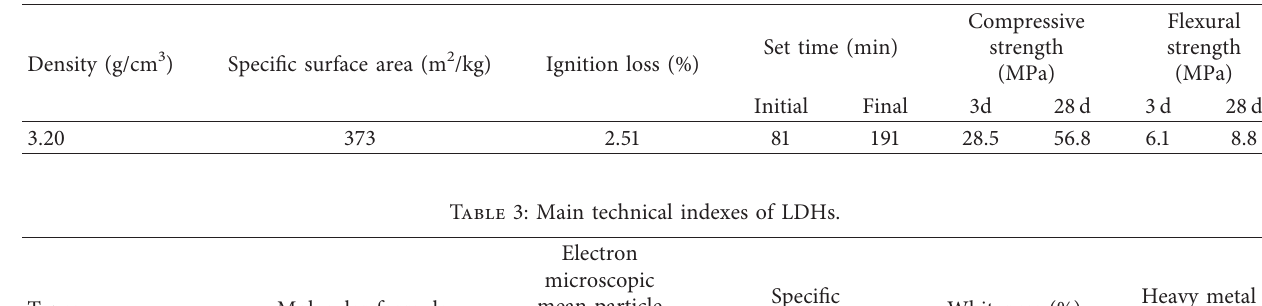
Table 2: Physical properties of cement.